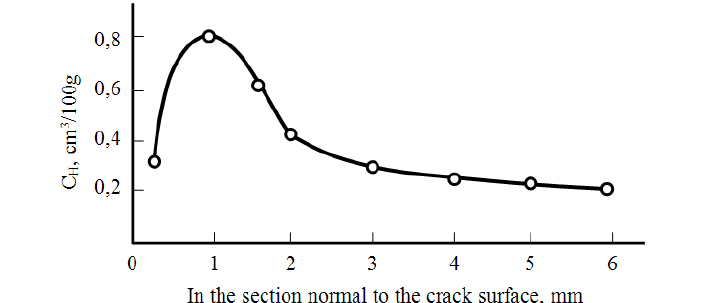
Figure 3: Hydrogen distribution C in the section normal to the crack surface at a distance of 3 mm behind the crack tip. H